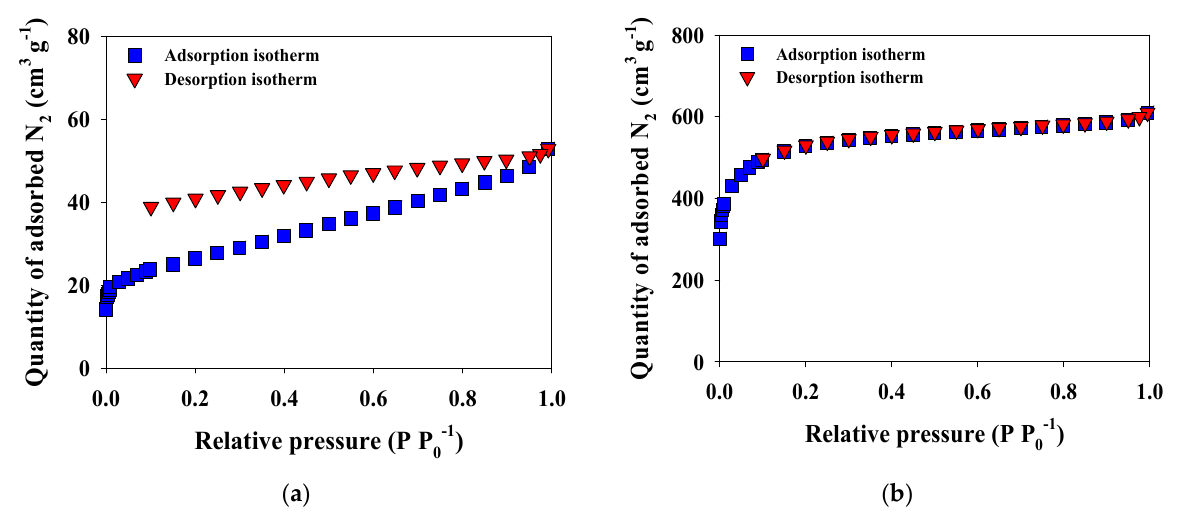
Figure 1. N 2 adsorption-desorption isotherm curves of the ( a ) peanut shell biochar (PSB) and ( b ) KMnO 4 and KOH modified PSB (PSB OX-A ). Table 2. Physicochemical characteristics of PSB and PSB OX-A .